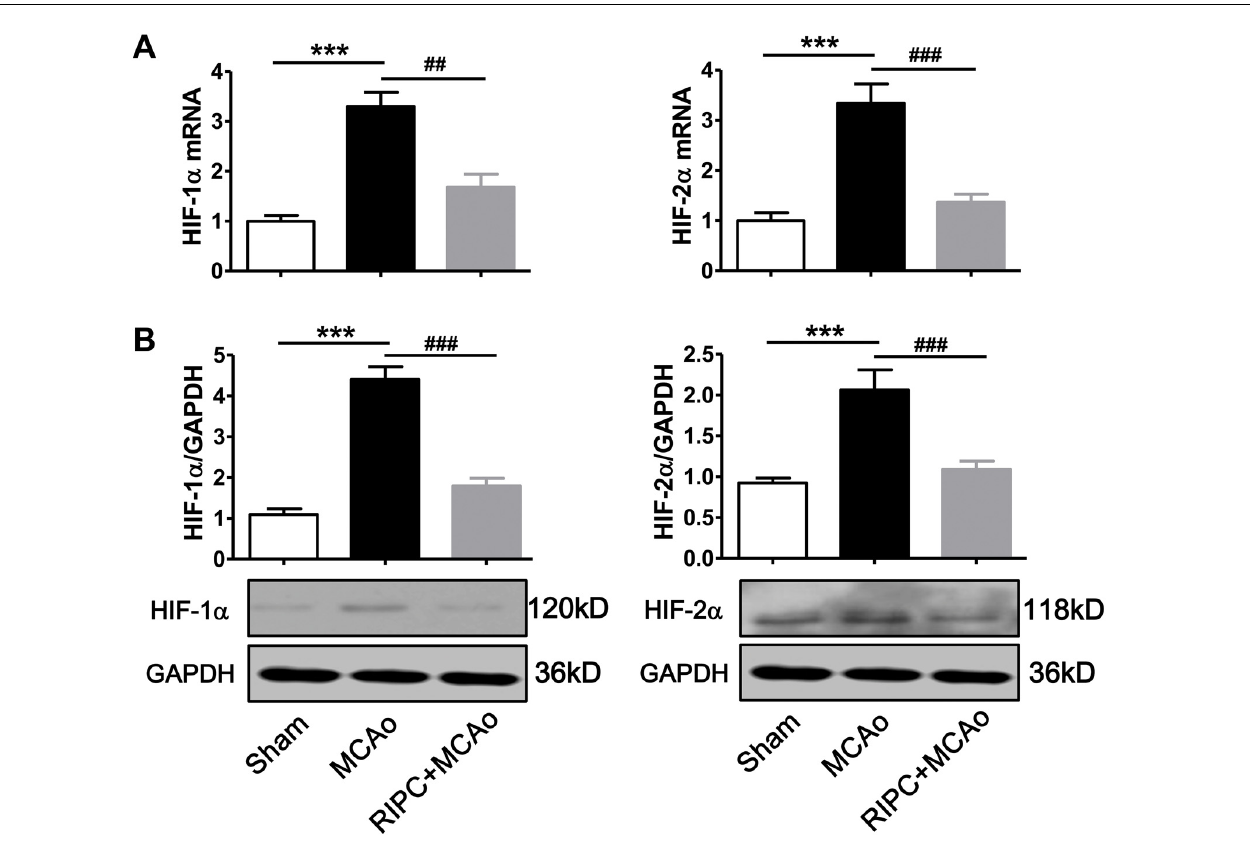
FIGURE 2 | The expression of HIF-1 α and HIF-2 α in penumbra tissues. (A) The mRNA level of HIF-1 α and HIF-2 α was assessed by real-time RT-PCR. (B) Statistical data and representative images of western blot of HIF-1 α and HIF-2 α protein levels in penumbra tissues in the Sham, MCAo and RIPC+MCAo group. ( N = 5–6 per group) Statistical analysis was performed by ANOVA. *** vs. Sham, p < 0.001, ##,### vs. MCAo, p < 0.01, 0.001,